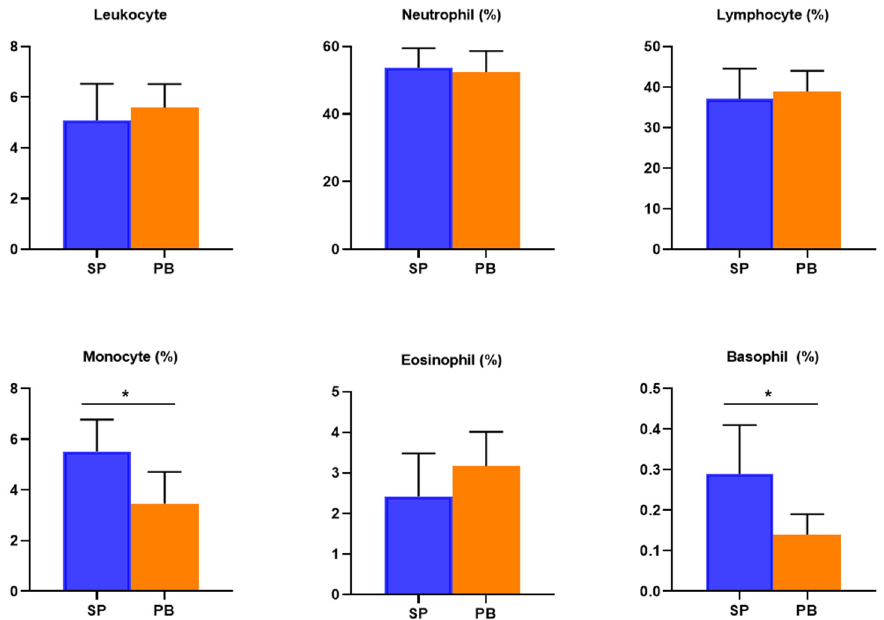
Figure 3. The difference of the post-test between the groups. Notes: Except the unit of leukocytes being 10 9 /L, the other parameters’ units are %. * p < 0.05.